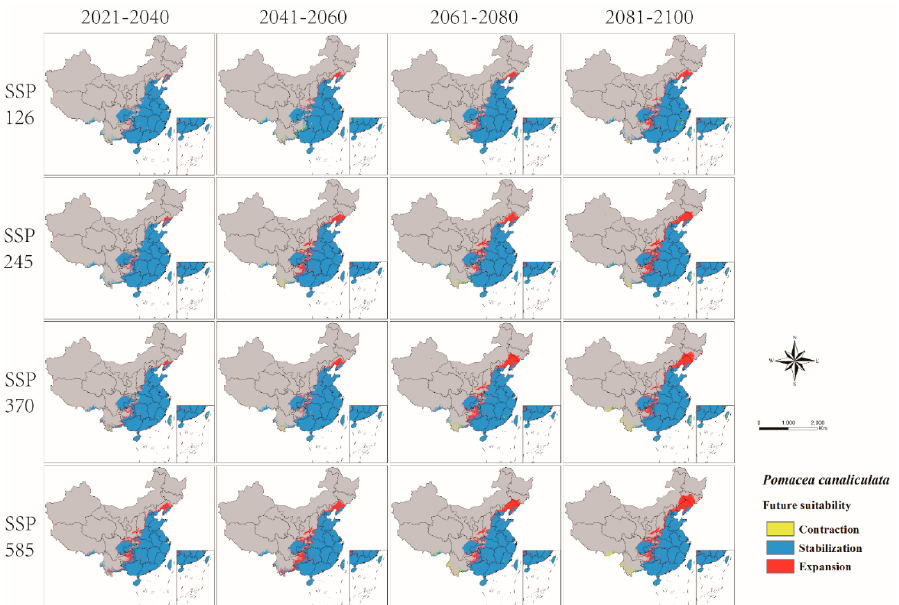
Figure 6. Changes in the potential distribution of P. canaliculata in China from 2021 to 2100 under four shared socioeconomic pathways (SSPs).